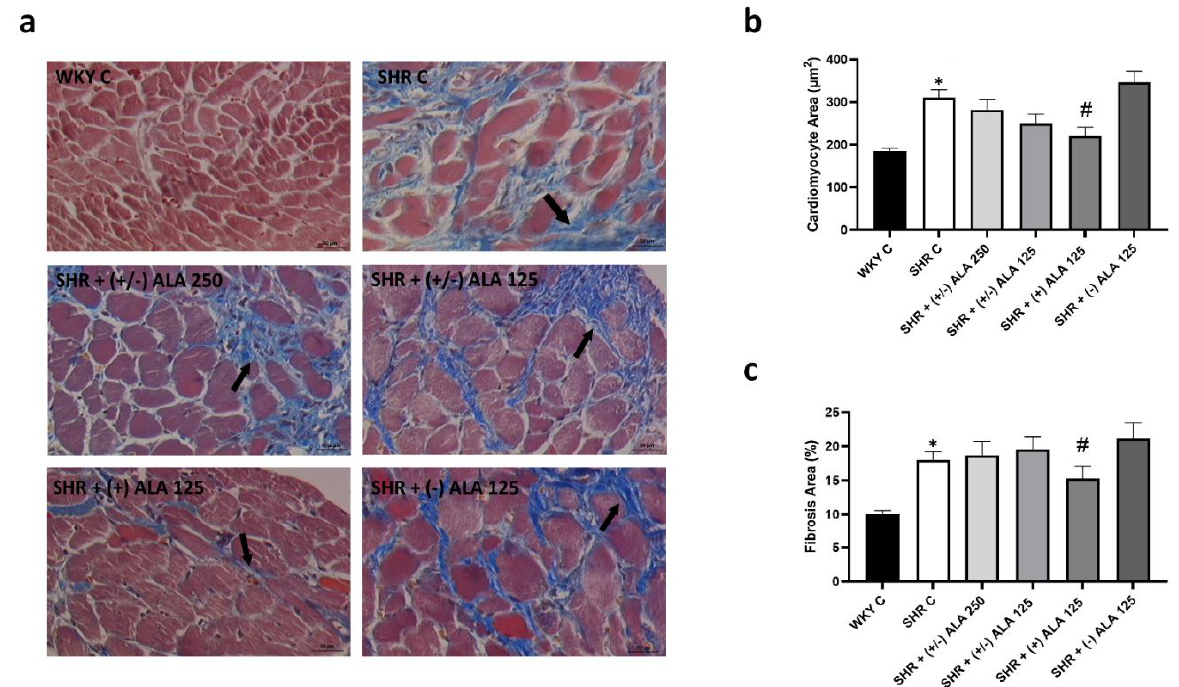
Figure 8. Heart morphology. ( a ) Cardiac tissue of WKY C, SHR C, SHR + (+/ − ) alpha lipoic acid (ALA) 250 µmol/kg/day, SHR + (+/ − ) ALA 125 µmol/kg/day, SHR + (+) ALA 125 µmol/kg/day, SHR + ( − ) ALA 125 µmol/kg/day were stained using Masson’s trichrome technique. Arrow: damaged cardiomyocytes. Calibration bar: 50 µm; ( b , c ) Morphometric analysis to evaluate the areas of cardiomyocytes and cardiac fibrosis, respectively. Data are mean ± S.E.M. * p < 0.05 vs. WKY C; # p < 0.05 vs. SHR C.